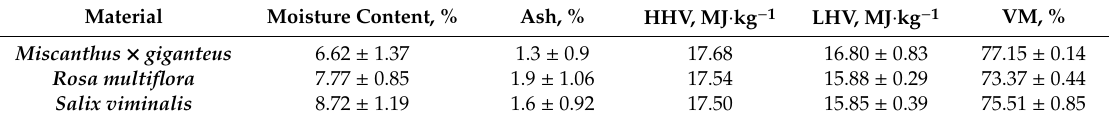
Table 2. Biomass